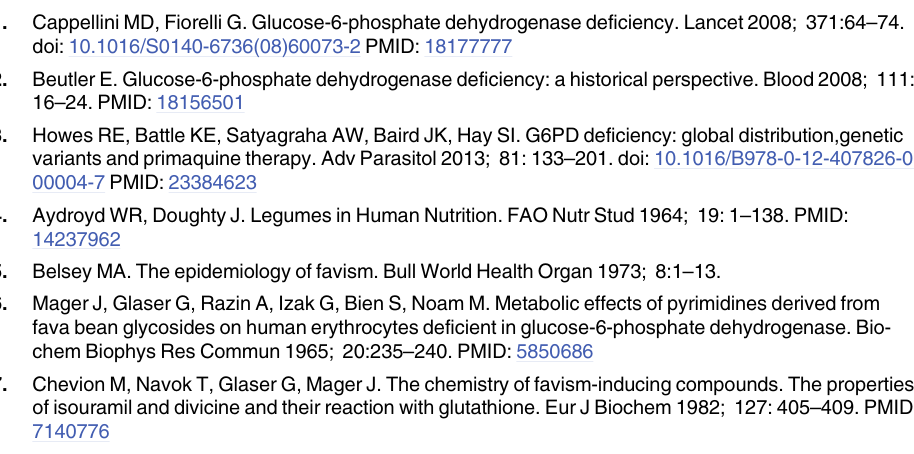
(TIF) S3 Fig. PLS-DA scatter plots of GC/MS data of extracts from plasma of mice. Orthogonal partial least-squares discriminant analysis (OPLS-DA) score plots (t(1)P/ t(2)O) of the plasma of C3H (A) group and G6PDx group (B). (TIF) S4 Fig. The representative GC/MS chromatograms of tissue liver samples from No.3 of C3H-C group, No.4 of C3H-FB group, No.4 of G6PDx-C group and No.4 of G6PDx -FB group. X-axis is retention time (min); Y-axis is intensity of MS (%). (TIF) S5 Fig. PCA scatter plots of GC/MS data of extracts from tissues Liver of mice. Principal Component Analysis (PCA) score plots (t(1)P/ t(2)O) of the liver of C3H (A) group and G6PDx group (B). (TIF) S6 Fig. PLS-DA scatter plots of GC/MS data of extracts from tissues Liver of mice. Orthogo- nal partial least-squares discriminant analysis (OPLS-DA) score plots (t(1)P/ t(2)O) of the liver of C3H (A) group and G6PDx group (B). (TIF) S7 Fig. The R 2 and Q 2 results of random permutation over at least n = 500 of GC/MS data of extracts from plasma of mice. (A) C3H group and (B) G6PDx group. (TIF) S8 Fig. The e R 2 and Q 2 results of random permutation over at least n = 500 of GC/MS data of extracts from liver of mice. (A) C3H group and (B) G6PDx group.